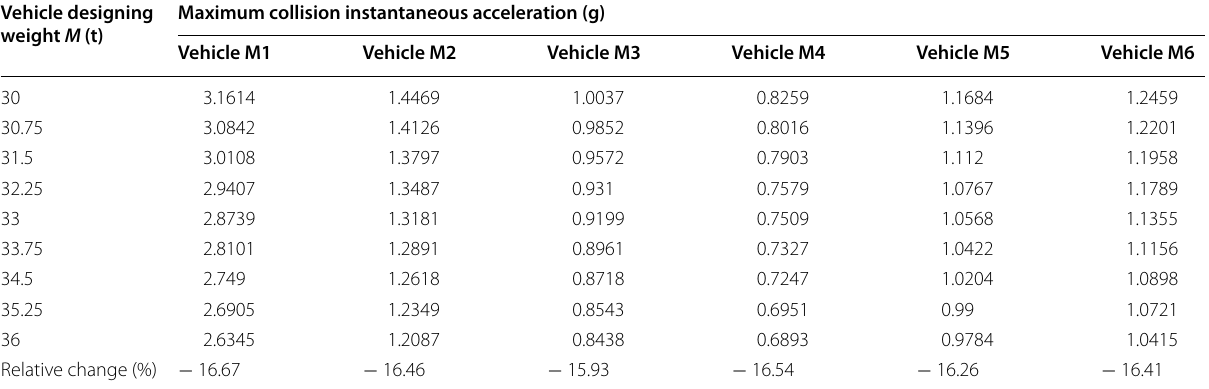
Table 7 Vehicle collision acceleration response under different M Vehicle designing weight M (t)